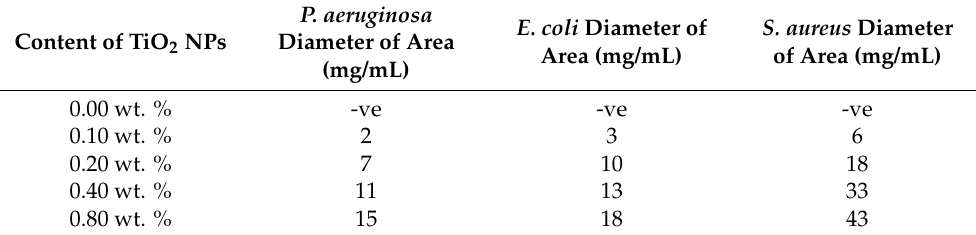
Table 3. Antibacterial activity of PEO/CMC filled with different content of TiO 2 NPs.